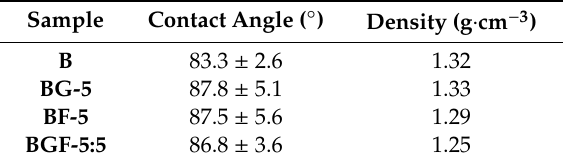
Table 15. Contact angles and densities of prepared composite materials base on recycled